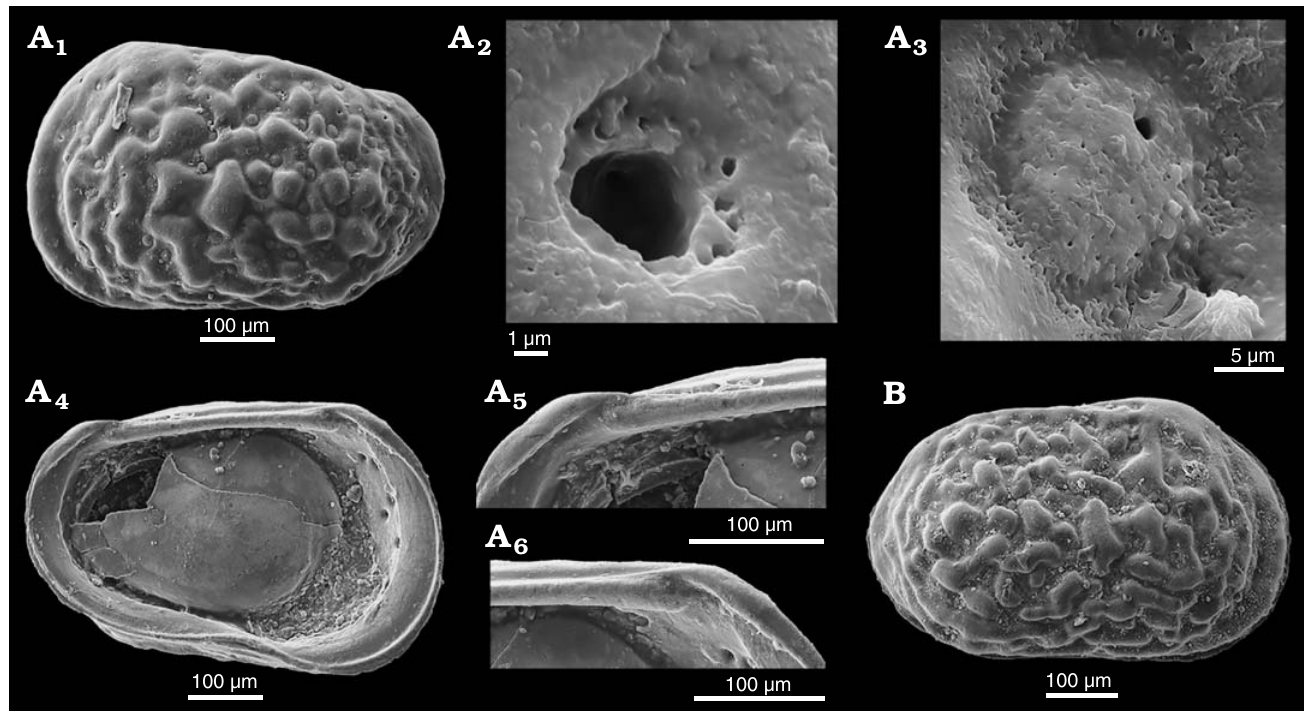
Fig. 17. Cytherid ostracod Minyocythere tuberculata (Luppold, 2012) from Borehole Rodewald WA12, 404.5 m, NW Germany, Lower Bajocian. A . SMF Xe 23754, female left valve in external (A 1 ) and internal (A 4 ) views, micro sieve-type pore canals (StPC-m) (A 2 ), macro sieve-type normal pore canals (StPC-M) (A 3 ), hinge, posterior (A 5 ) and anterior (A 6 ) parts. B . SMF Xe 23755, female right valve in external